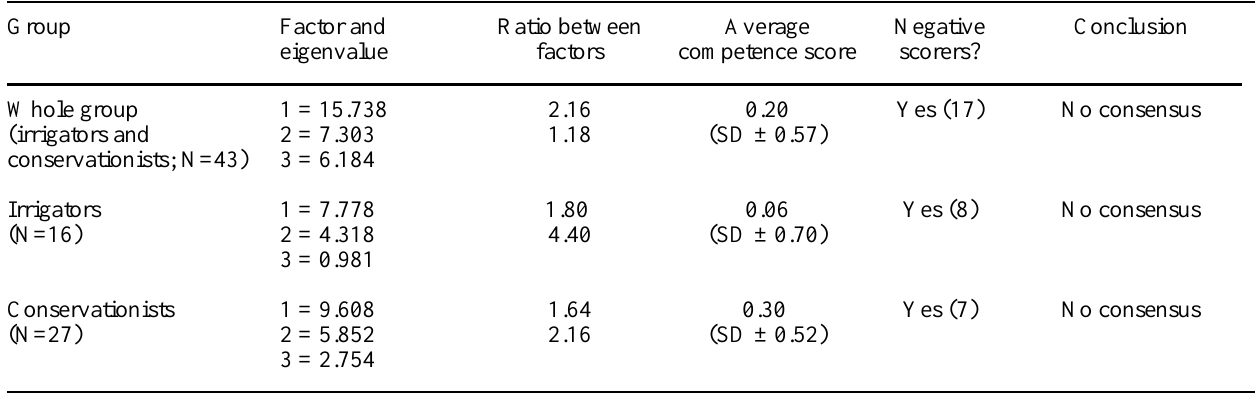
Negative scorers? Yes (17) No consensus Yes (8) No consensus